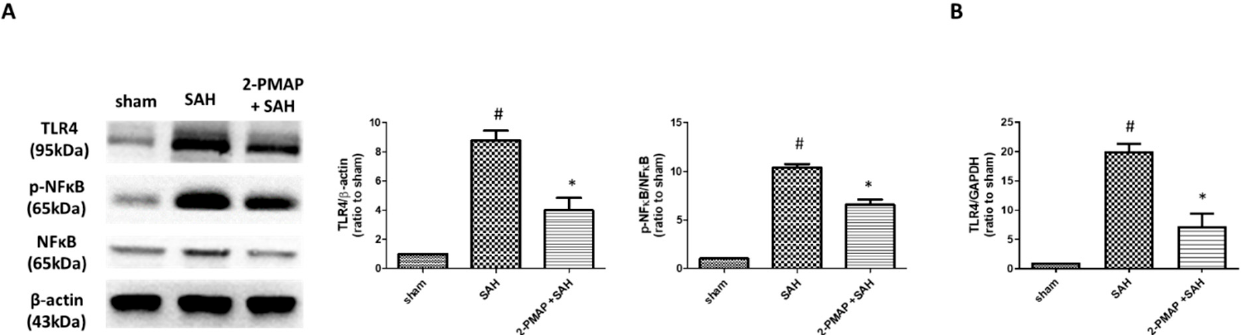
Figure 4. 2-PMAP reduced the TLR-4/NF- κ B signals in SAH rats. ( A ) Western blotting was utilized to measure the protein levels of TLR-4, NF- κ B and phospho-NF- κ B in brain tissues. Left panel: representative expression of TLR-4, NF- κ B and phospho-NF- κ B protein of brain tissues. Beta-actin was used as an internal control. Right panel: quantification of TLR-4 and relative p-NK- κ B activity. ( B ) qRT-PCR was used to test the relative expression of TLR-4 in the BA. The level of TLR-4 in the BA was significantly increased after SAH, whereas 2-PMAP also reduced the level. Data are shown as mean ± SD ( n = 6 for each group); *, p < 0.05, significantly different from the SAH group. #, p < 0.05, significantly different from the sham group.